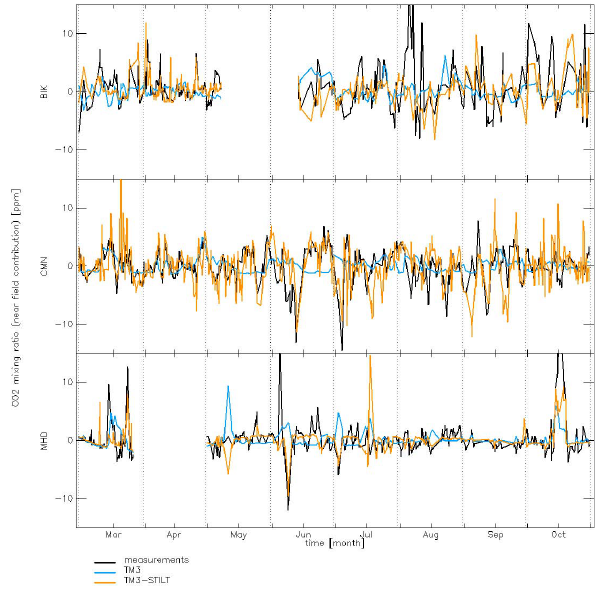
Fig. 2. Time series of the measured and modelled near-field CO 2 signal for year 2006 at three locations: BIK - a flat-terrain conti- nental tall tower site in eastern Poland, CMN - a mountain station in Italy, and MHD – coastal station in western Ireland. The seasonal component of the signal has been subtracted from the time series.